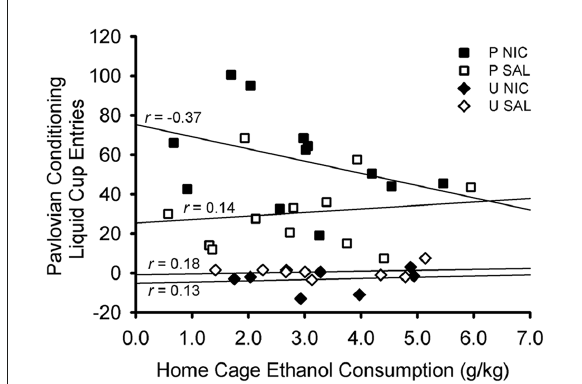
FIGURE4 Scatterplot showing the non-significant correlations between terminal levels of home cage ethanol consumption and Pavlovian conditioned responding. Ethanol consumption was averaged across the last two sessions of home cage ethanol access. Liquid cup entries made in response to the CS (with pre-CS baseline responding subtracted) were averaged across the last two sessions of Pavlovian conditioning. Each symbol represents an individual rat. Symbol shape and color indicate behavioral training group and drug group: black squares denote rats in the paired nicotine group, white squares denote rats in the paired saline group, black diamonds denote rats in the unpaired nicotine group, and white diamonds denote rats in the unpaired saline group. Pearson’s r values are indicated for each treatment